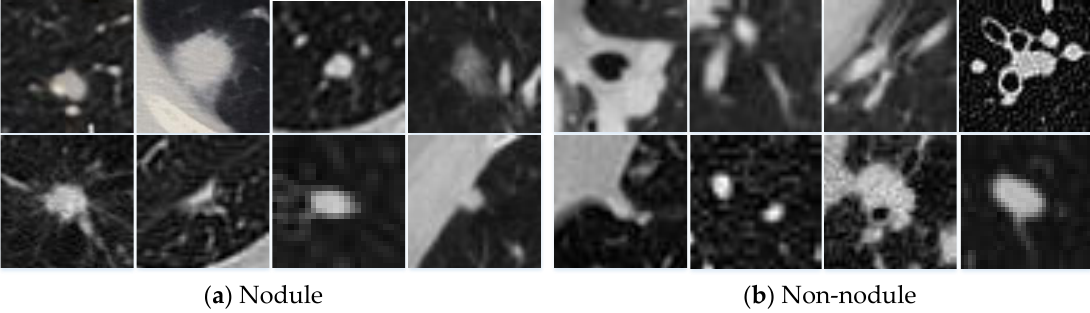
Figure 1. Examples of pulmonary nodules and non-nodules carrying similar structures. Each example is a two-dimensional (2D) transverse plane extracted from the location of the candidate nodule.